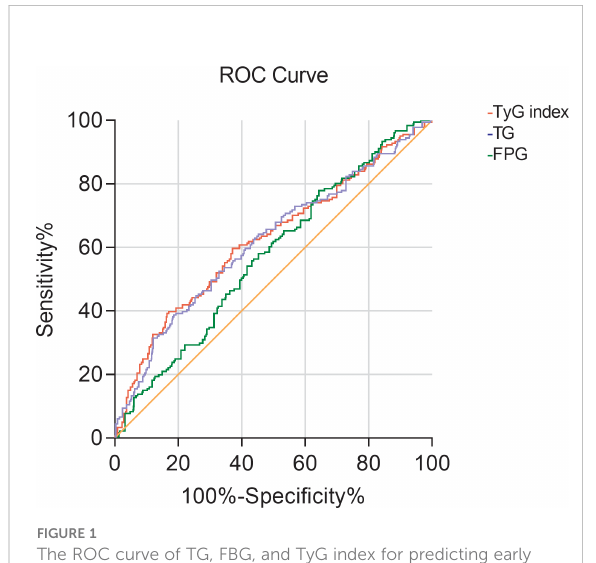
FIGURE 1 The ROC curve of TG, FBG, and TyG index for predicting early renal impairment ( b 2-MG>2.4mg/L) in patients with hypertension.